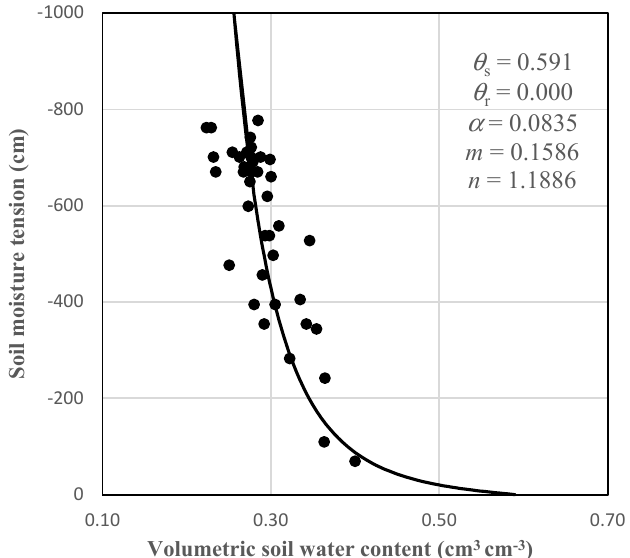
Figure 1. Representation of the h ( θ ) relationship of the soil profile at 0.30 m depth. Table 2. Global radiation ( GR ), temperature ( T ), relative humidity ( RH ), vapor pressure deficit ( VPD ), potential evapotranspiration ( ETo ), and rain during the experimental work (February to June 2019).